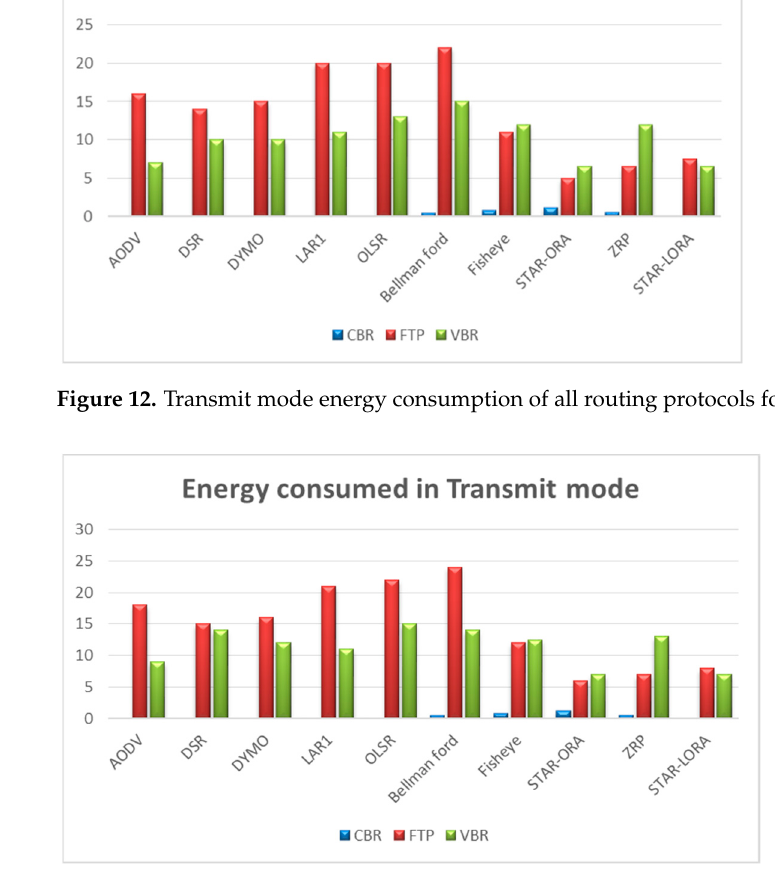
Figure 13. Transmit mode energy consumption of all routing protocols for 120 nodes .